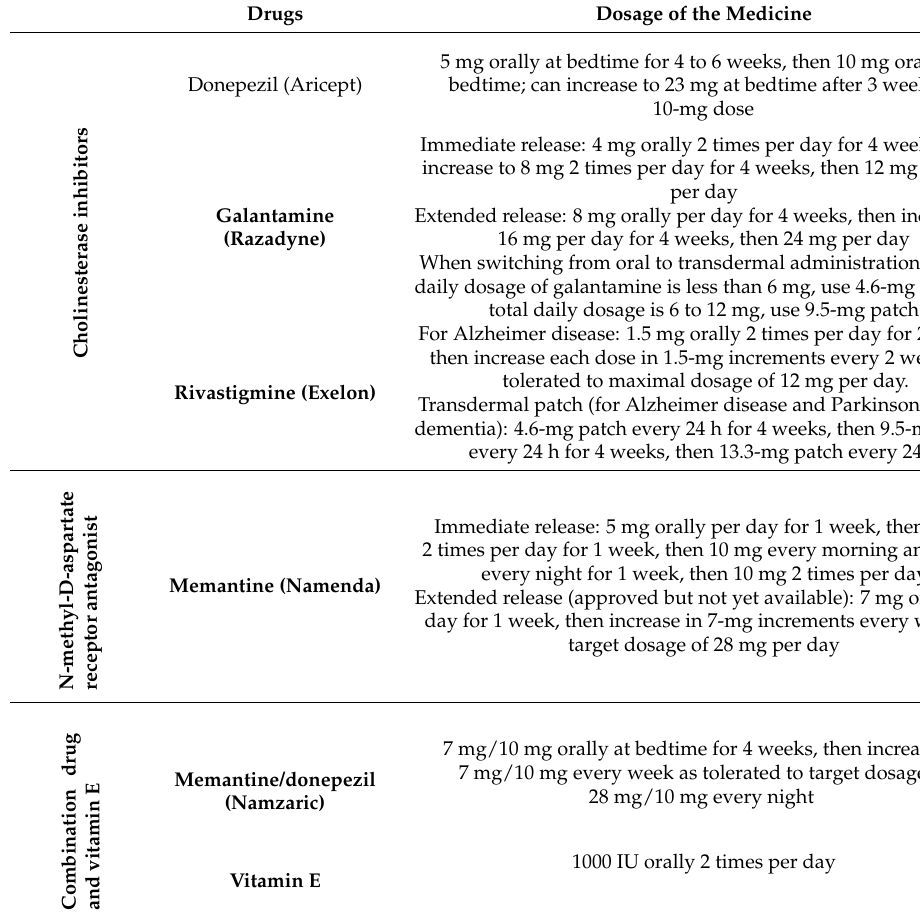
Table 1. Pharmacologic therapies for the management of Alzheimer